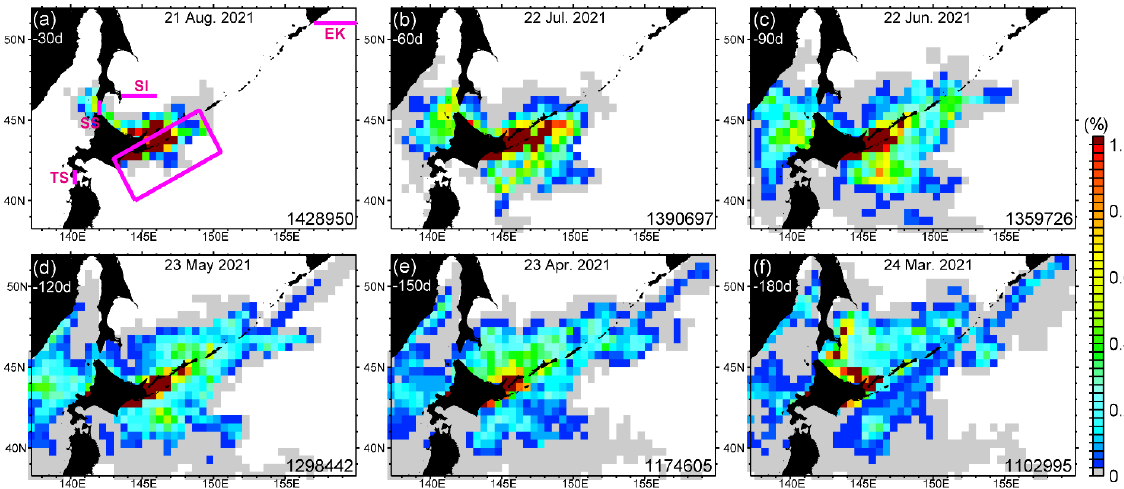
Figure 10. Relative frequencies of particles in 1/2° quadrats. This figure is basically the same as Figure 9, but for an enlarged domain and a time interval of 30 days. Particle-tracking simulations based on five initial times (10, 15, 20, 25, and 30 September 2021) were merged on the basis of the elapsed time of particle tracking from the initial time: ( a ) 30, ( b ) 60, ( c ) 90, ( d ) 120, ( e ) 150, and ( f ) 180 days. Calendar dates along the top of each panel represent the date that the particle-tracking simulation was initialized based on a particle release date of 20 September 2021. Positions of transects EK (“East Kamchatka”), TS (“Tsugaru Strait”), SS (“Soya Strait”), and SI (“Sakhalin Island”) are denoted by pink lines in ( a ). The pink rectangle indicates the focal area of this study.